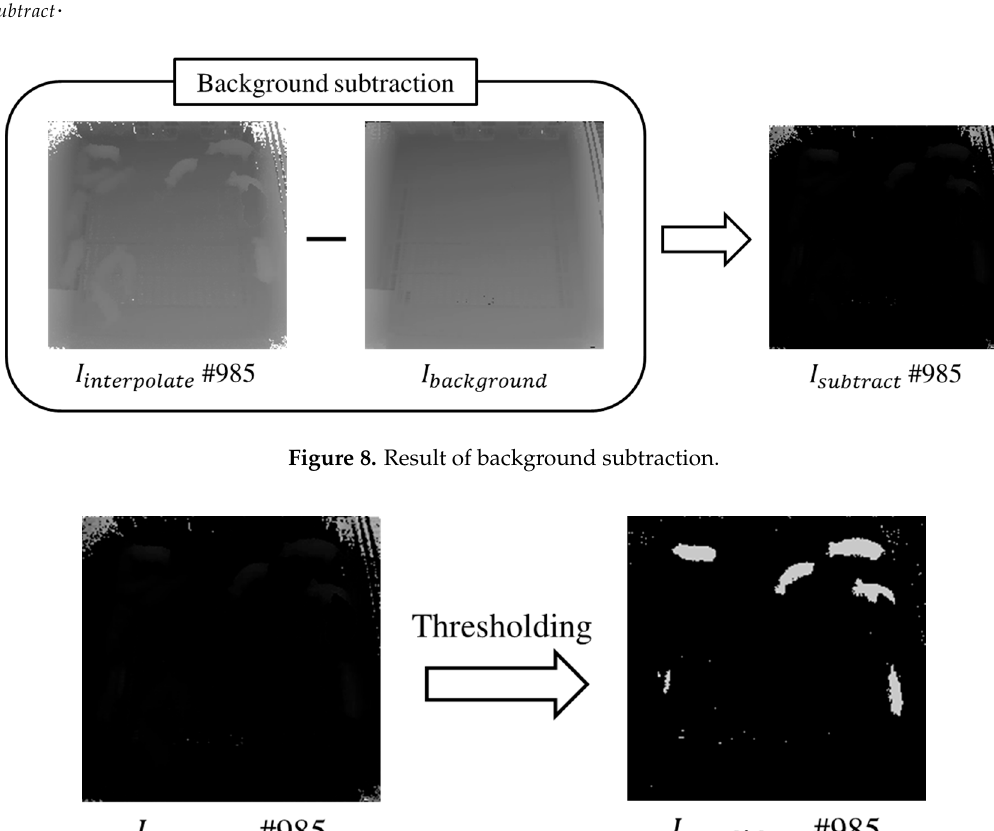
Figure 9. Candidates detected as standing-pigs.